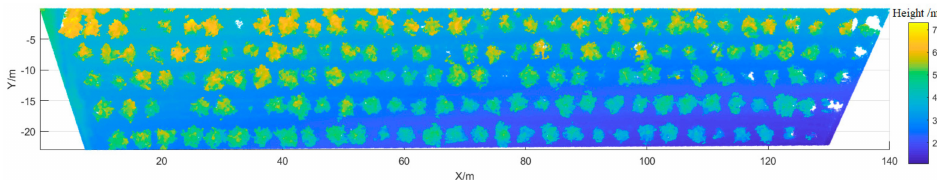
Figure 2. 3D point-cloud model of the orchard (XOY plane view, GSD = 2.13 cm /